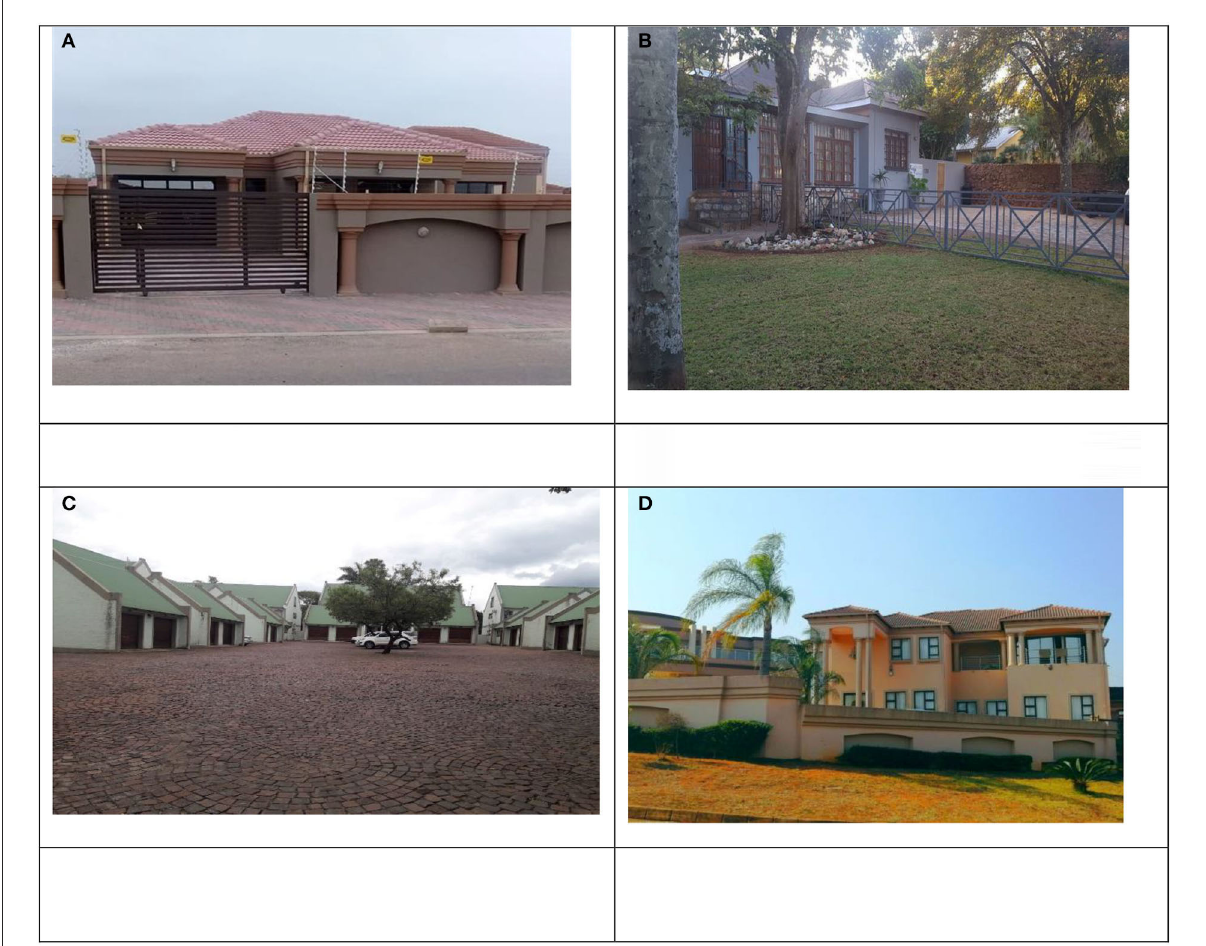
FIGURE4 Buildingscapes skyline and architectural changes over time in Louis Trichardt. (A) Modern house with high wall, electric fence, and transparent electric gate. (B) Old style (1970–1980s) house with tree and steel open fencing and gardening. (C) Gated community housing estate with open communal courtyard. (D) Modern double storey building—open and closed landscaping and elevation security designs at